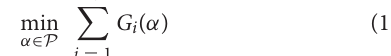
TABLE 1 | CAPEX, OPEX, lifetime, and optimal nominal capacities of the energy sources and storage systems (for MW-scale systems) in the three options.